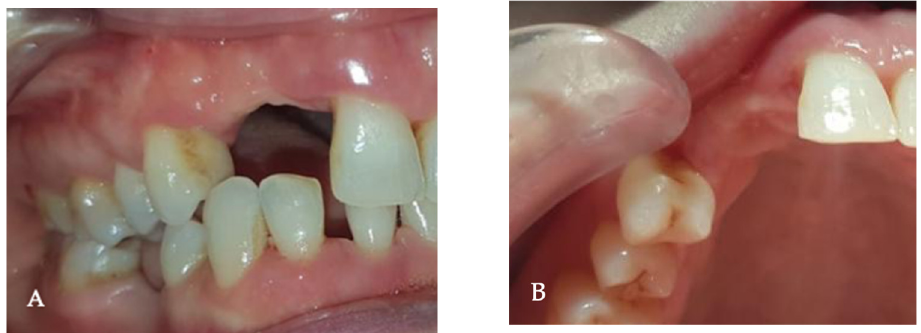
Figure 1. The initial intraoral aspect of the patient proposed a gingival graft before the bone augmen- tation: ( A ) the buccal view, ( B ) the occlusal view.